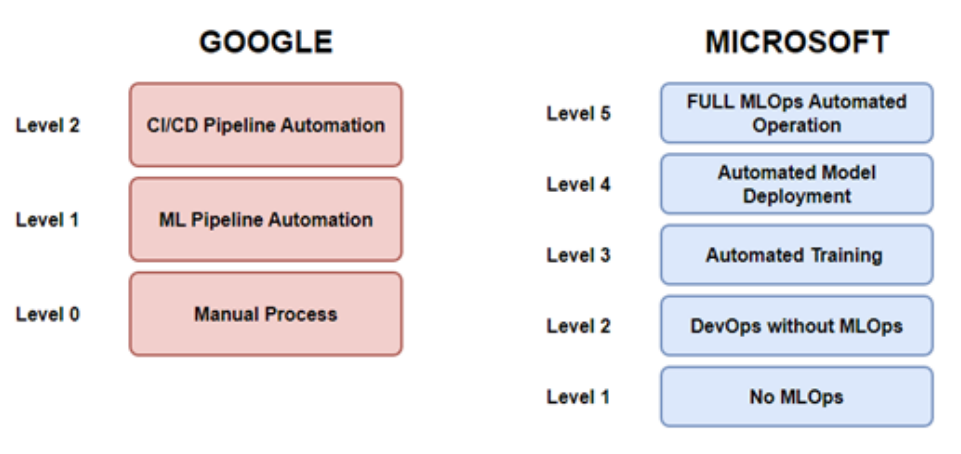
Figure 9. Machine Learning Operations Maturity